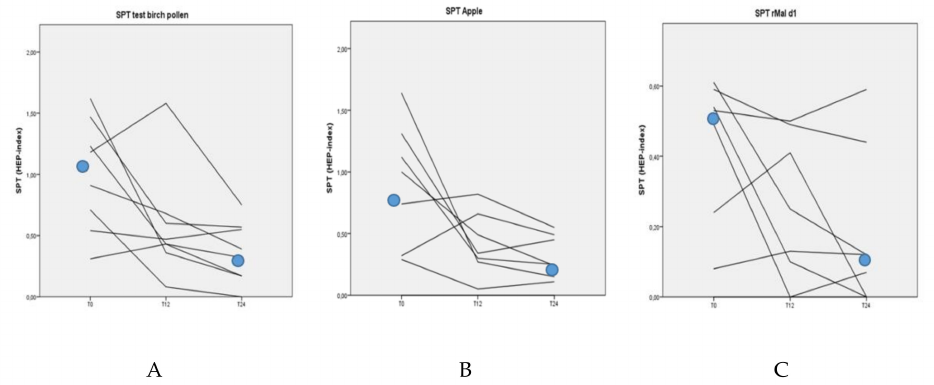
Figure 1. Skin prick test (SPT) results with birch pollen ( A ), apple ( B ) and rMal d 1 ( C ) over time (in months) during birch pollen allergen-specific immunotherapy (BP-AIT).